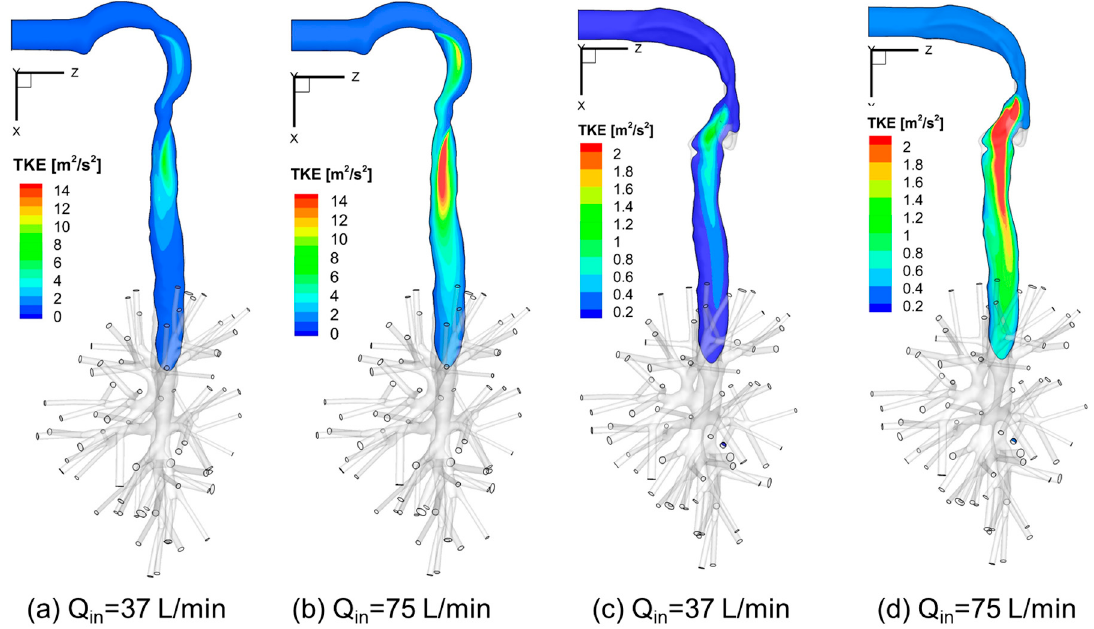
Figure 11. Turbulence Kinetic Energy (TKE) distributions at sagittal planes under different inhalation flow rates: ( a ) Q in = 37 L/min for Geometry C; ( b ) Q in = 75 L/min for Geometry C; ( c ) Q in = 37 L/min for Geometry A; ( d ) Q in = 75 L/min for Geometry A.